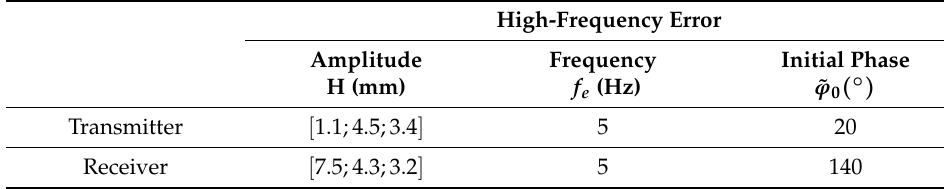
Table 2. High-frequency error parameters in simulation.